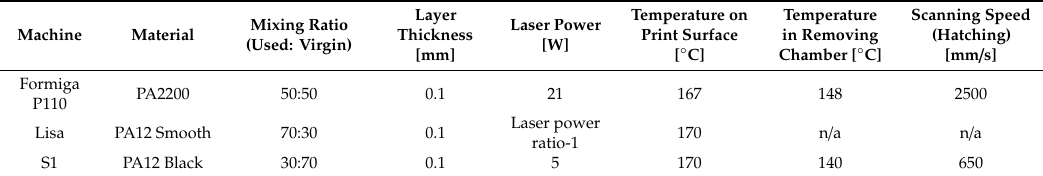
Table 2. Laser Sintering Process Parameters Used to Produce Parts According to Each